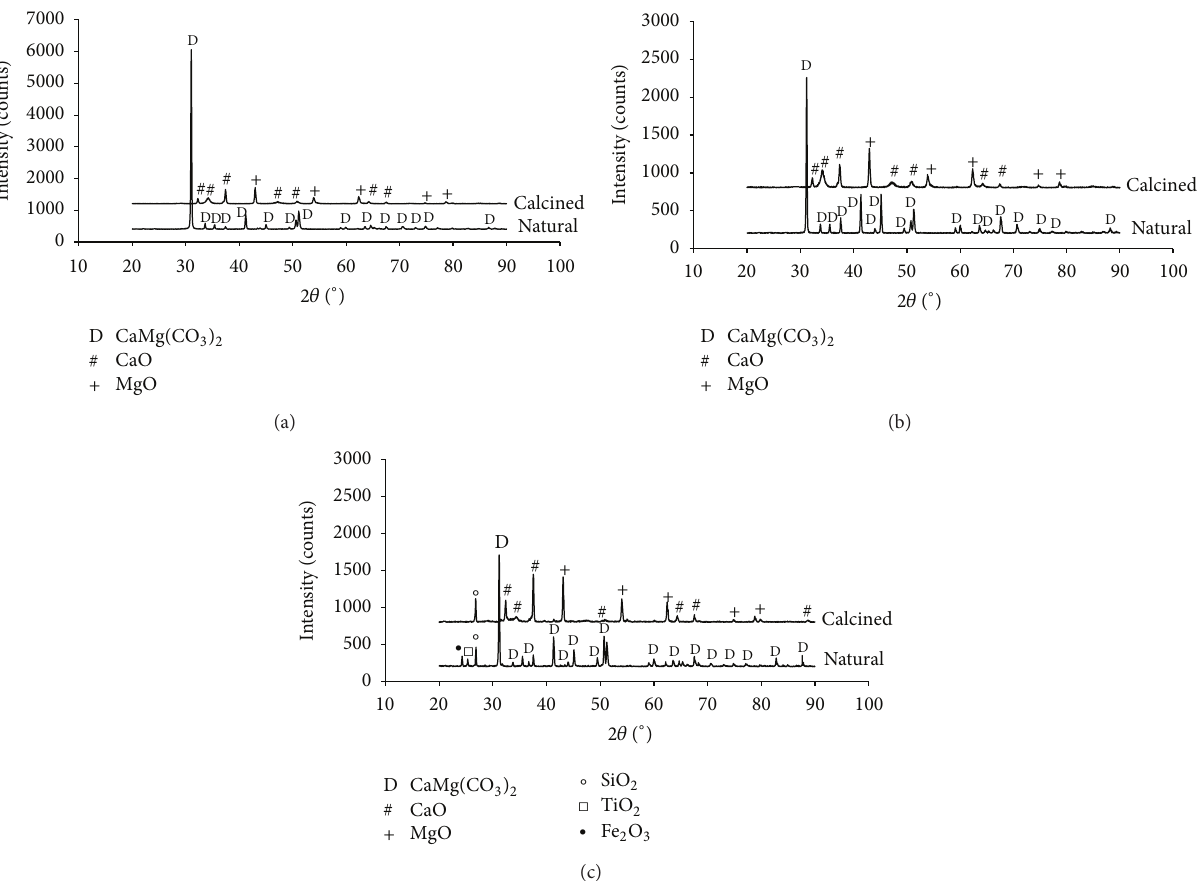
amount of pure dolomite for tar cracking [14]. In general, dolomites with the lowest content of CaO and MgO show the lowest tar cracking efficiency